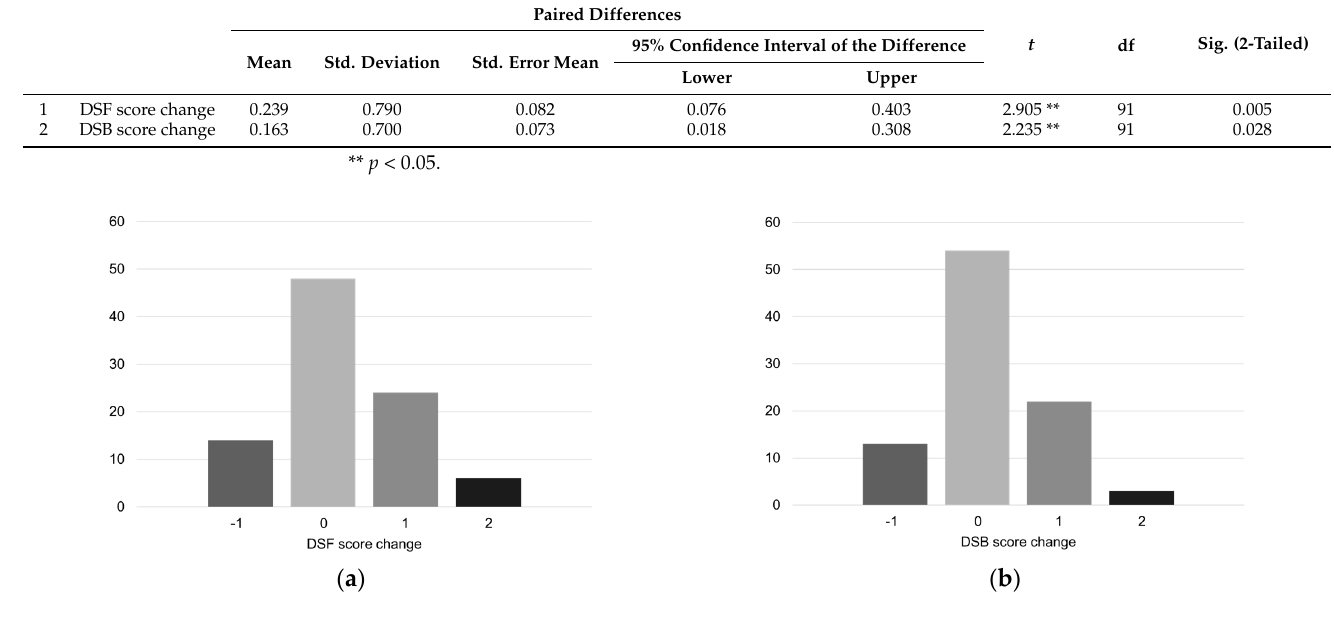
Figure 4. ( a ) DSF test results; ( b ) DSB test results.